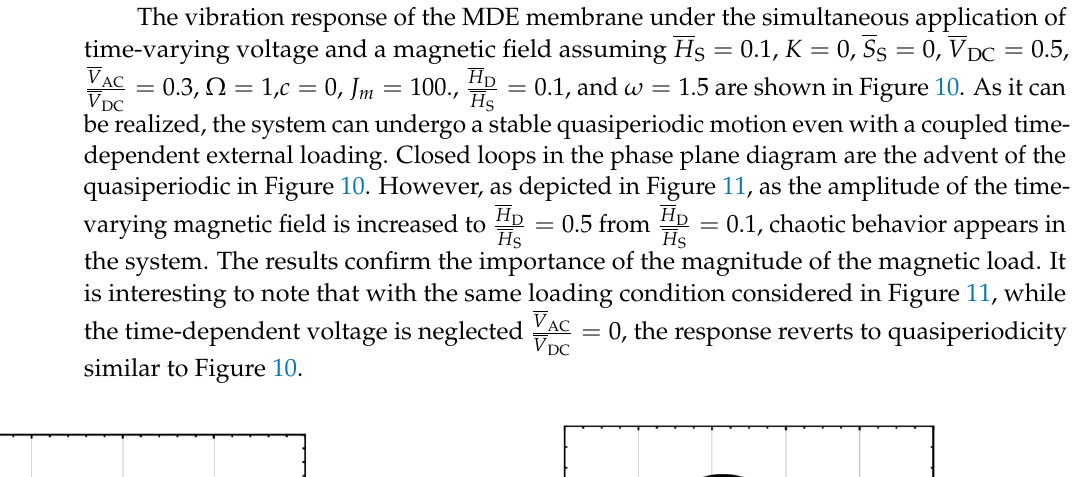
Figure 9. The dynamic response of the electro-magneto-active polymer to J m = 40. ( a ) Time history and ( b ) phase plane diagram with Poincaré map inside it.